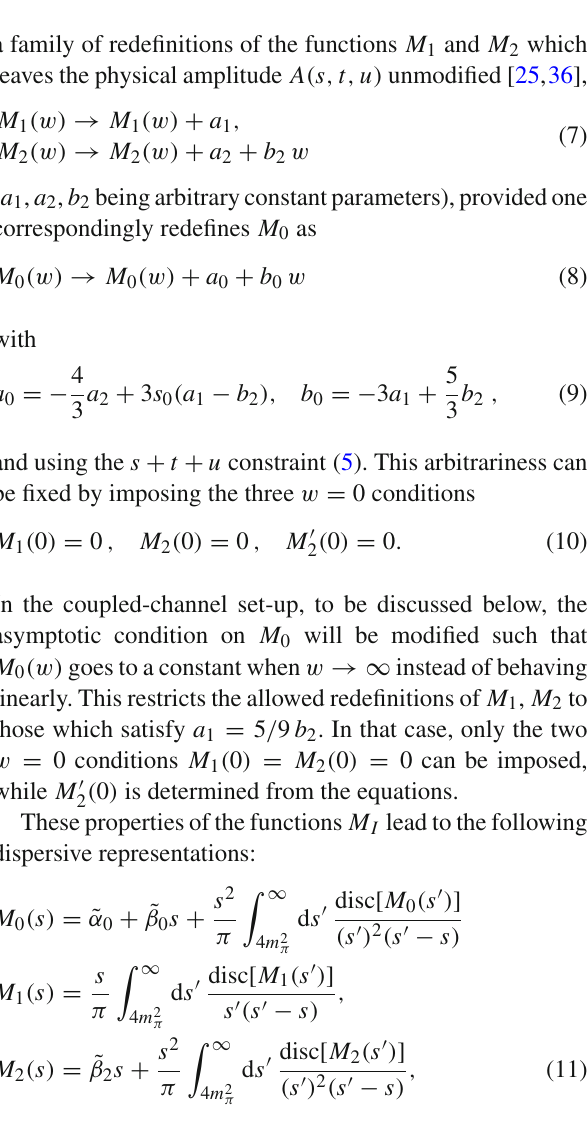
Fig. 1 Mandelstam plane showing the physical regions for η → 3 π decay and for ηπ → ππ